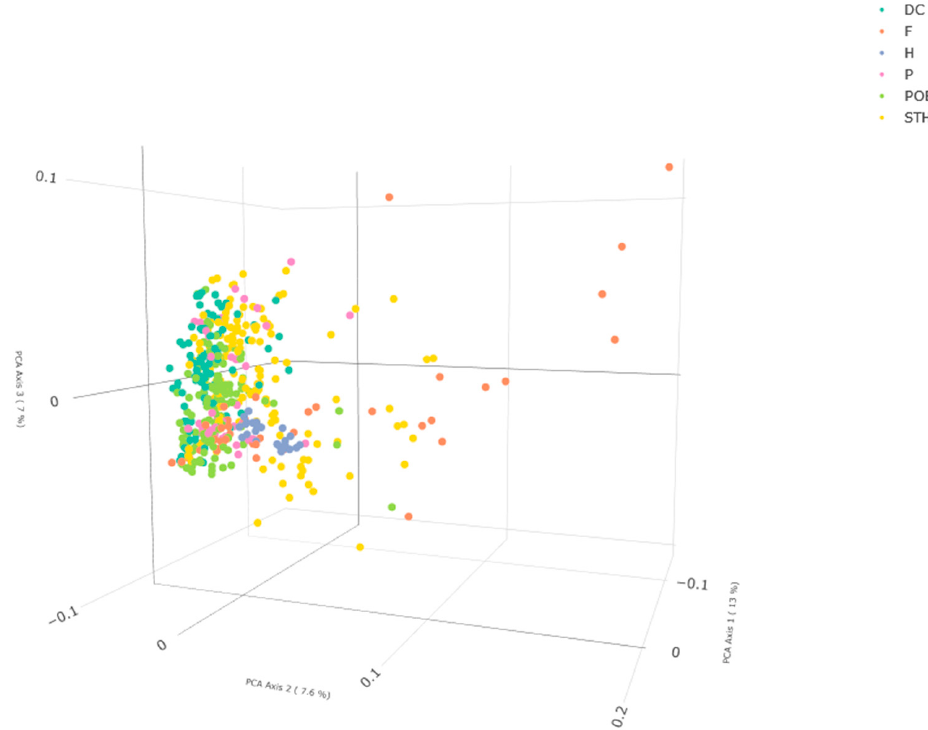
Figure 4. Three-dimensional plot of the principal coordinate analysis results for DArTseq data of 487 A. sativa accessions. Results in the first three coordinates’ system. Each point denotes one